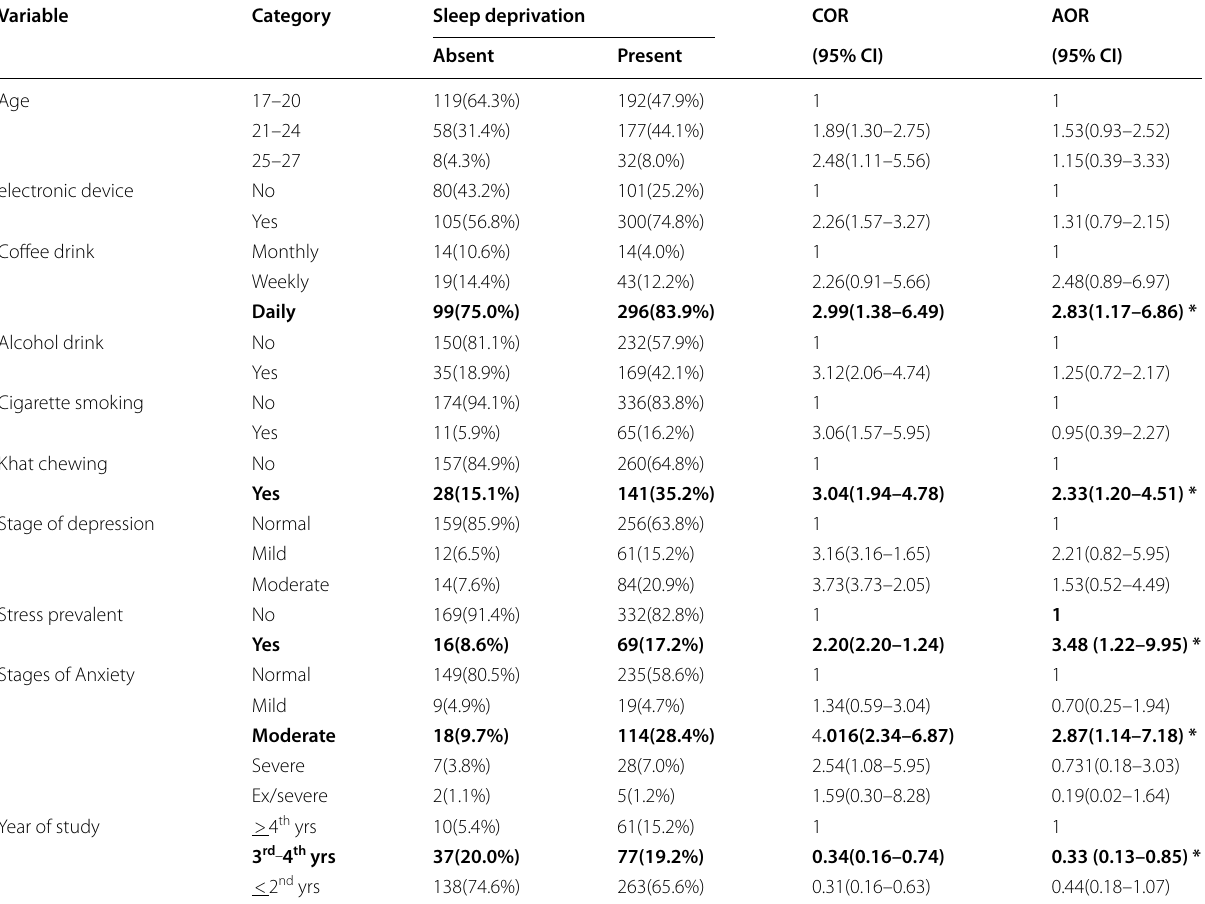
Table 3 Bivariable and multivariable logistic regression model of factors associated with sleep deprivation among